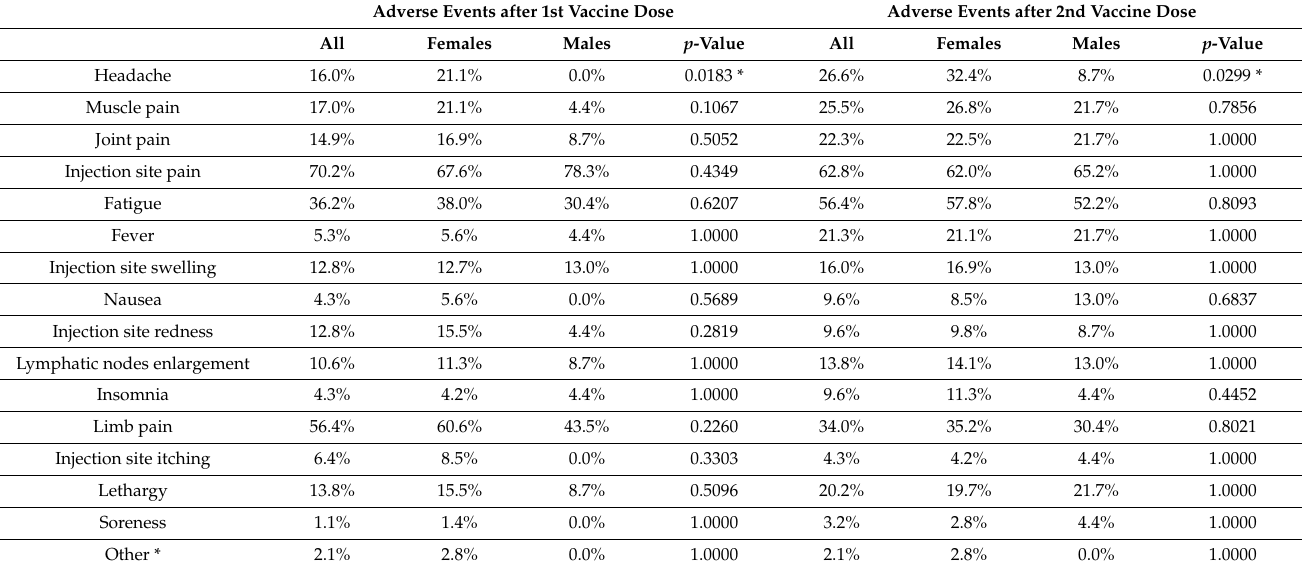
Table 4. Incidence of adverse events by gender. * Other adverse events that respondents mentioned after first vaccination were eyelash edema, tearing, and herpes labialis; after second vaccination: pain